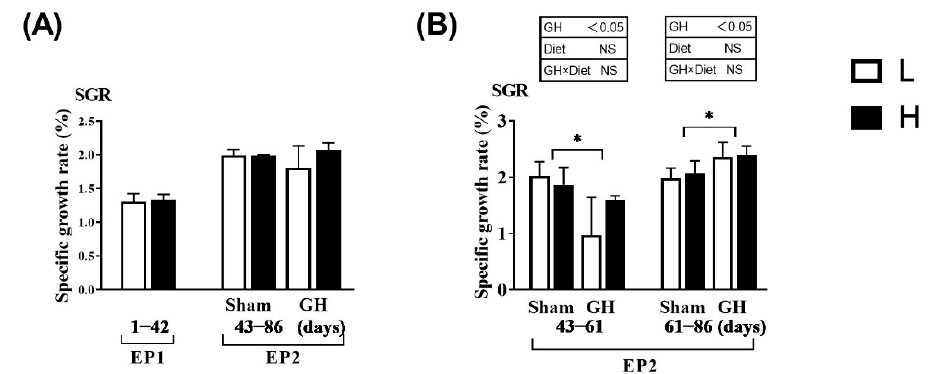
Figure 2. Specific growth rate in Atlantic salmon in response to dietary vitamins and growth hormone (GH) implantation or sham implantation over EP1 and EP2. The specific growth rate is calculated over the EP1 from 0 to 42 days, EP2 from 42 to 60 days as well as 61 to 86 days. Data presented as means ± SD. p -values obtained from two-way ANOVA on the main effects of diet, GH, and interaction are provided in insets. * Significant effect of treatment ( p < 0.05, two-way ANOVA).